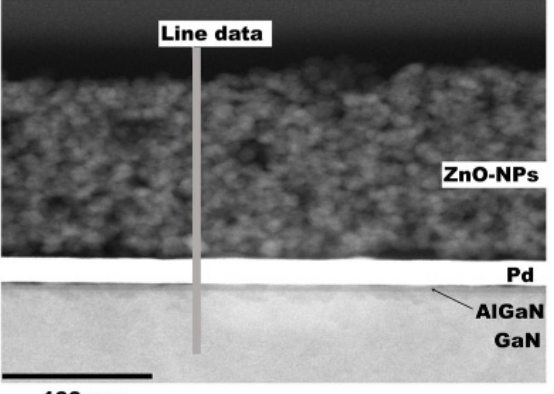
Figure 11. TEM analysis for ZnO-NPs/Pd dual catalyst layer of the AlGaN/GaN-on-Si hydrogen sensor [110].